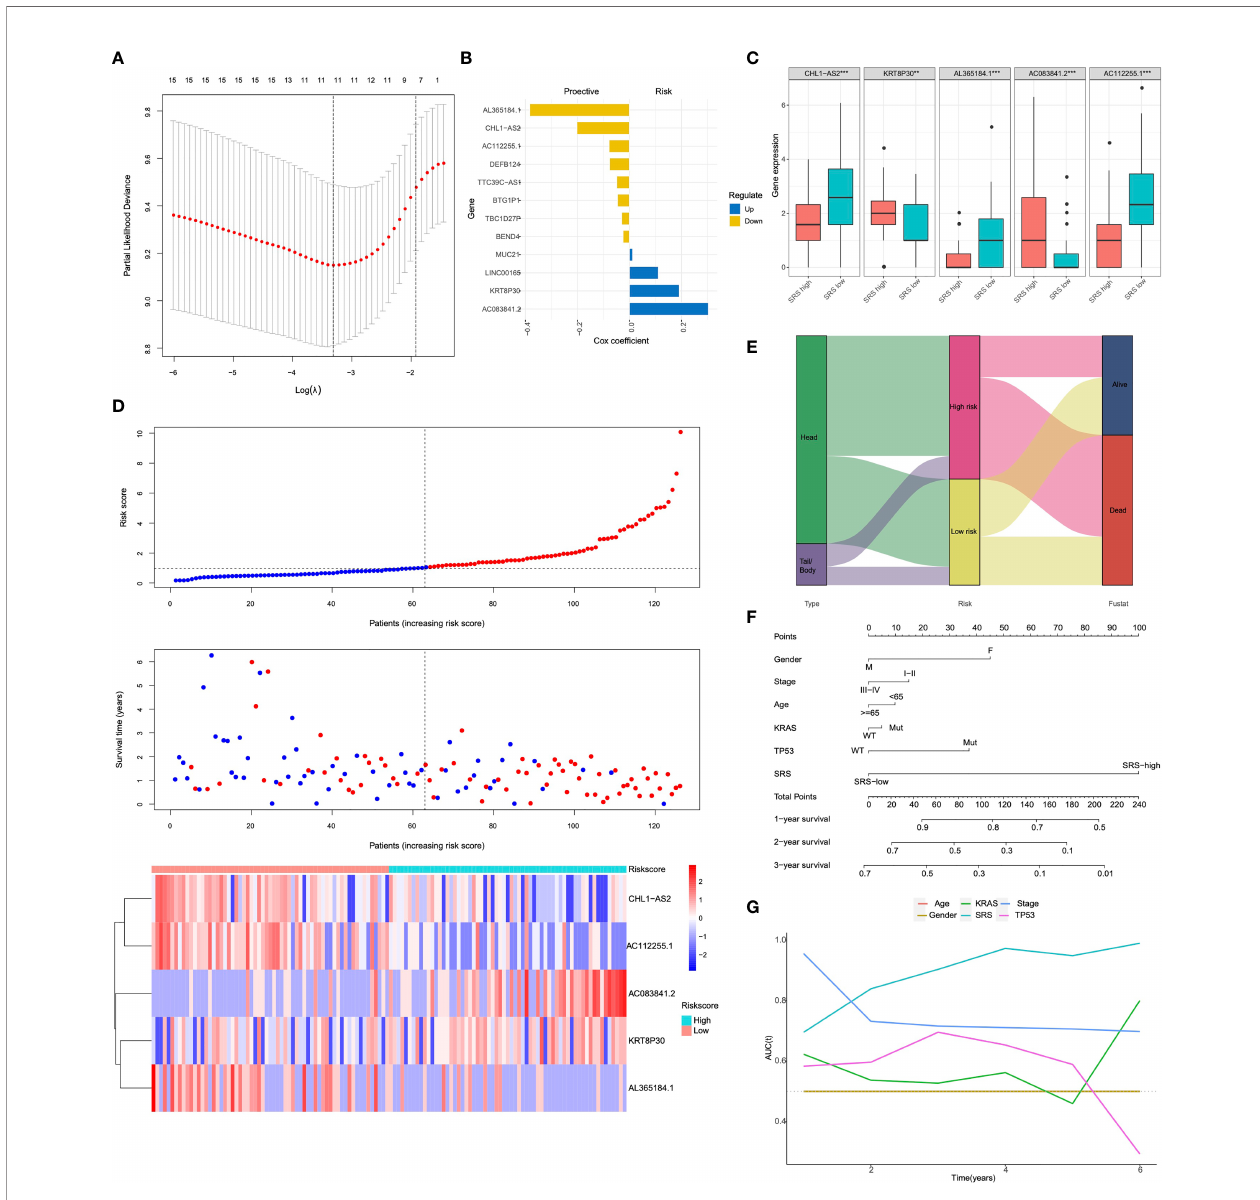
FIGURE 3 | The anatomical site-related risk score (SRS) establishment (A) The LASSO Cox regression model was used to identify the most robust markers with an optimal l value of 0.0617. (B) Distribution of LASSO coef fi cients of the anatomical site-related gene signature. (C) Expression levels of 5 selected genes between SRS-high and SRS-low tissues in TCGA database. (D) SRS model of the head and body/tail of pancreatic cancers. The top section showed the survival status of PAAD patients. Y-axis represented survival time of each patient. The middle section of fi gure showed the SRS. X-axis represented the patient IDs, which were ranking by SRS score from low to high. The heatmap of bottom showed CHL1-AS2, KRT8P30, AL365184.1, AC083841.2 and AC112255.1 expression in each PAAD patients. (E) a Sankey diagram depicted the fl ow from two different anatomical site to SRS and pathological fustate, in which the width of the fl ow rate is proportional to the patient number. (F) A nomogram was constructed to quantify risk assessment for individual patients. (G) tROC analysis demonstrated that the nomogram was the most stable and powerful predictor for OS among all the clinical variables. LASSO, least absolute shrinkage and selection operator; SRS, the anatomical site-related risk score; ROC, receiver operating characteristic; tROC, time-dependent receiver operating